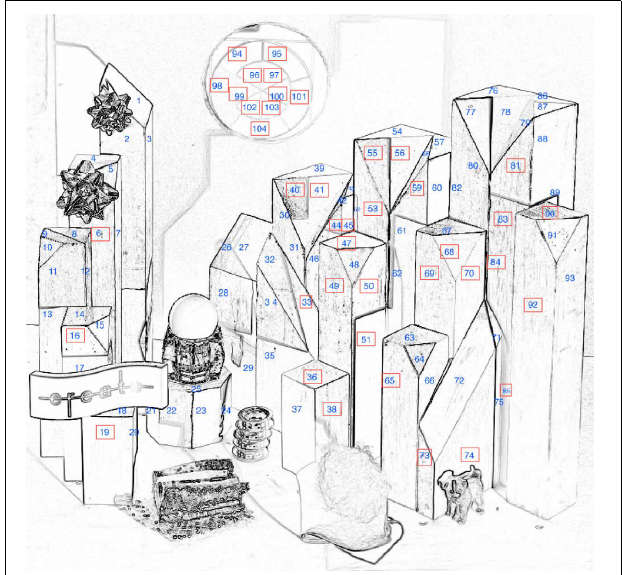
FIGURE 4 | Identification numbers for the 104 wooden block facets. The red rectangles identify the 37 facets evaluated by magnitude estimation.